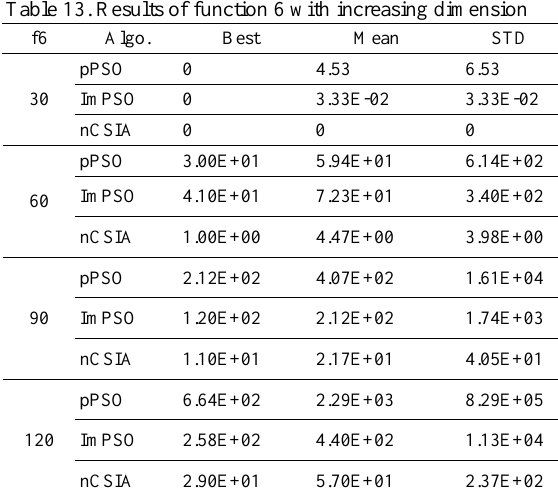
Table 10. Results of function 12 with expanding domain